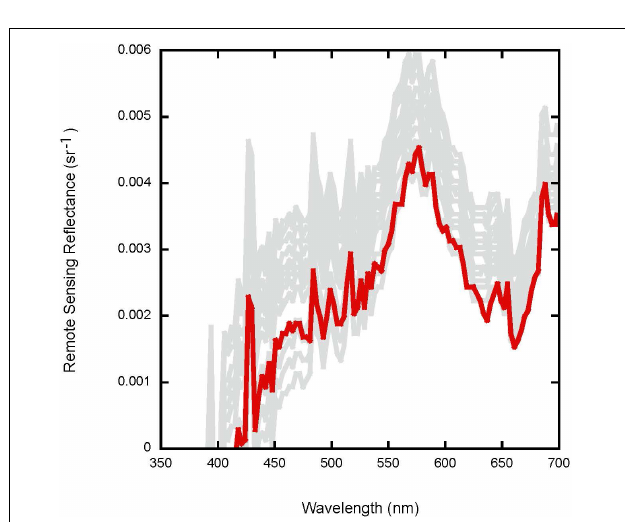
FIGURE 5 | A sensitivity analysis of the atmospheric correction for CST18 from the COAST 2011 mission was performed. The red line indicates the best retrieval (compared to C-AIR and C-OPS) from HIS, while the gray lines indicate retrievals using three atmospheric models in Tafkaa and 6SV with measured AOD values. The best fit falls within the range of reasonable spectra, but without direct measurement of in-water (C-OPS) or LSA data (C-AIR), there is no basis for quantitatively selecting the best